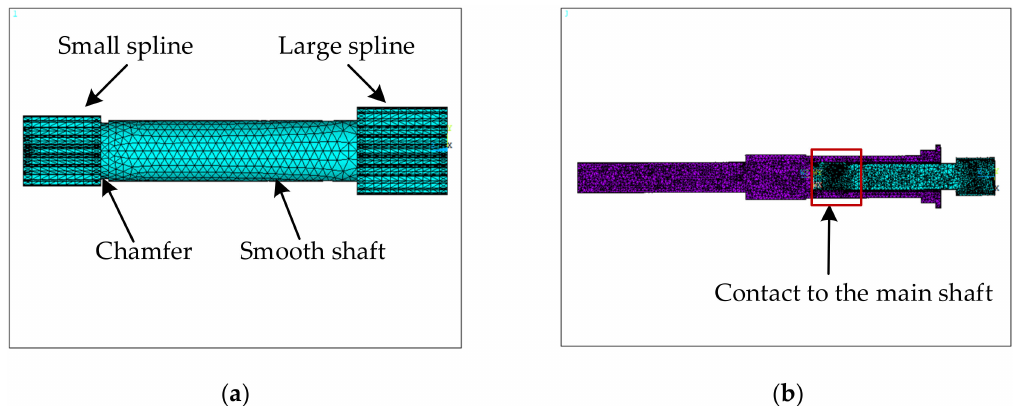
Figure 6. The finite element model of a spline shaft: ( a ) overall model; ( b ) an extended model with connection to the main